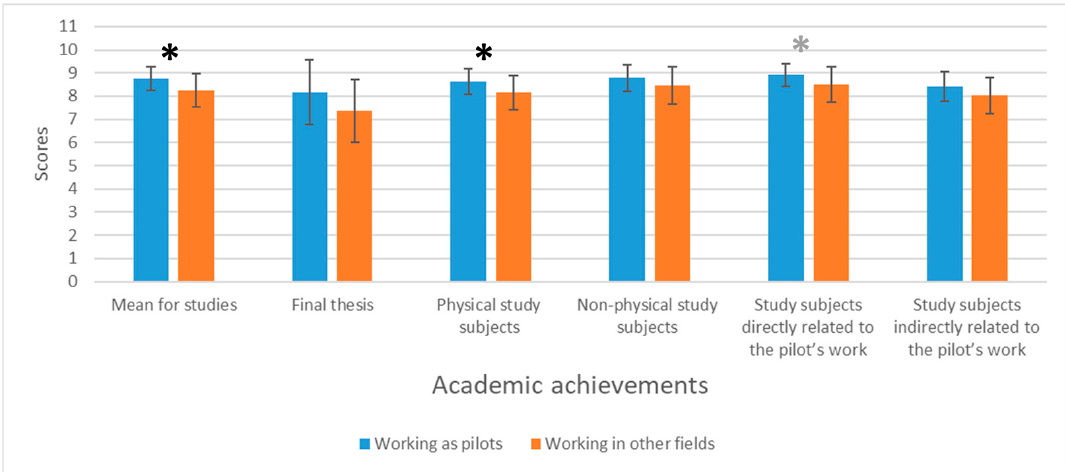
Figure 3. Study outcomes (source: created by the authors). Statistically significant differences are marked. Black asterisk: p < 0.05; grey asterisk: p = 0.05.